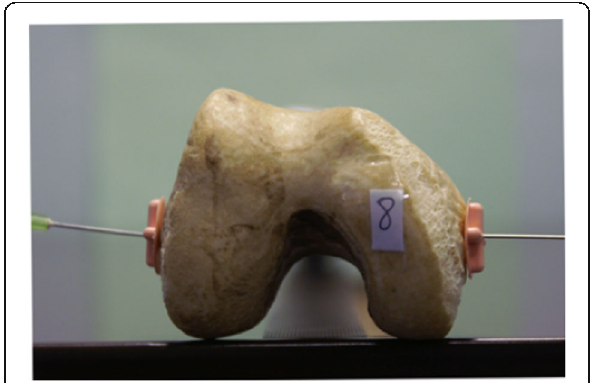
Fig. 2 Photographic image along femoral anatomical